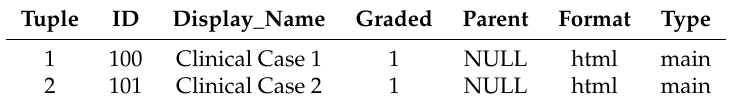
Table 1. Relation module in a Massive Open On-line Course (MOOC) platform [13].